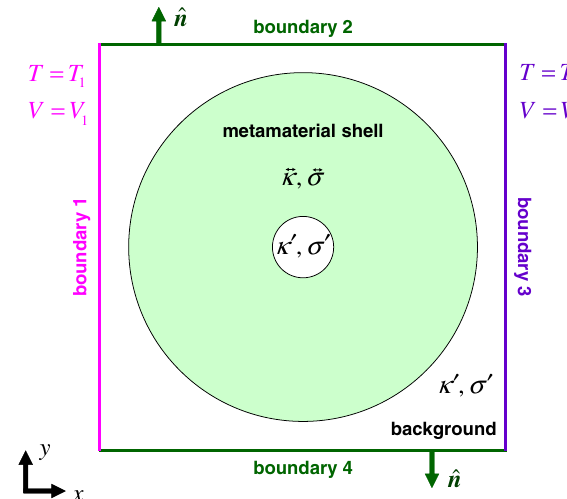
FIG. 2. Schematic of the computational domain considered in the finite-element numerical simulations, consisting of a square of side length L ¼ 28 cm filled with a background material with constitutive parameters κ 0 and σ 0 , and a metamaterial annular shell of radii R 1 ¼ 2 cm and R 2 ¼ 12 cm. Also indicated are the boundary conditions enforced at the left and right boundaries (1 and 3, respectively), as well as the outward normal unit vectors involved in the thermal- and electrical-insulation conditions enforced at the boundaries 2 and